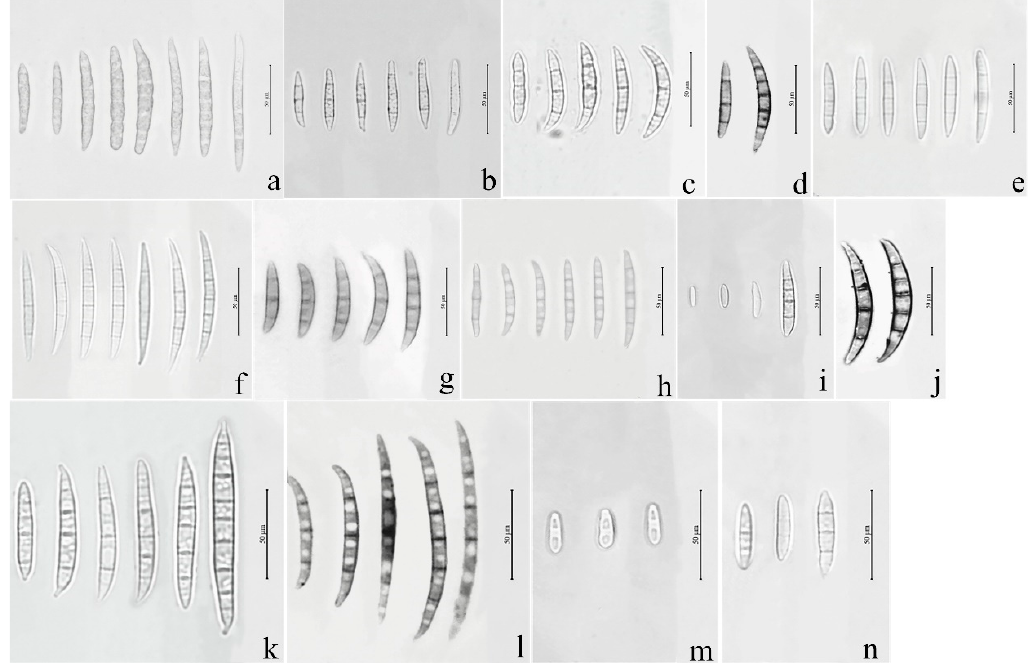
Figure 1 . Macroconidia or microconidia of representative isolates of 14 Fusarium species. ( a ) F. compactum ; ( b ) F. ipomoeae ; ( c ) F. citri ; ( d ) F. flagelliforme ; ( e ) F. temperatum ; ( f ) F. acuminatum ; ( g ) F. armeniacum ; ( h ) F. asiaticum ; ( i ) F. annulatum ; ( j ) Fusarium sp.; ( k ); F. graminearum ; ( l ) F. glycines ; ( m ) F. verticillioides ; ( n ) F. sporotrichioides . Fourteen F. sporotrichioides isolates produced dense, pinkish white to carmine red aer- ial mycelia, whose macroconidia were moderately curved to straight with three to five septa, but mostly three-septate, and measured 20.5 to 47.3 μ m × 2.8 to 4.2 μ m ( n = 30, Fig- ures 1 n and 2f). The colonies of four F. armeniacum isolates were white to light pink. The macro- conidia were prominently curved with three to five septa and had sizes ranging from 35.6 to 59.3 μ m × 4 to 4.6 μ m ( n = 30, Figures 1g and 2g).